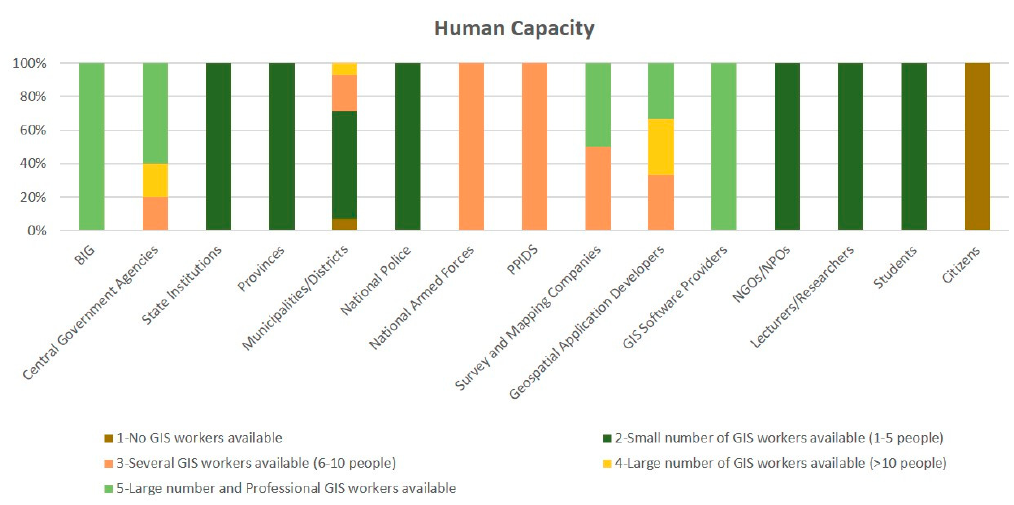
Figure 6. Questionnaire results on human capacity.